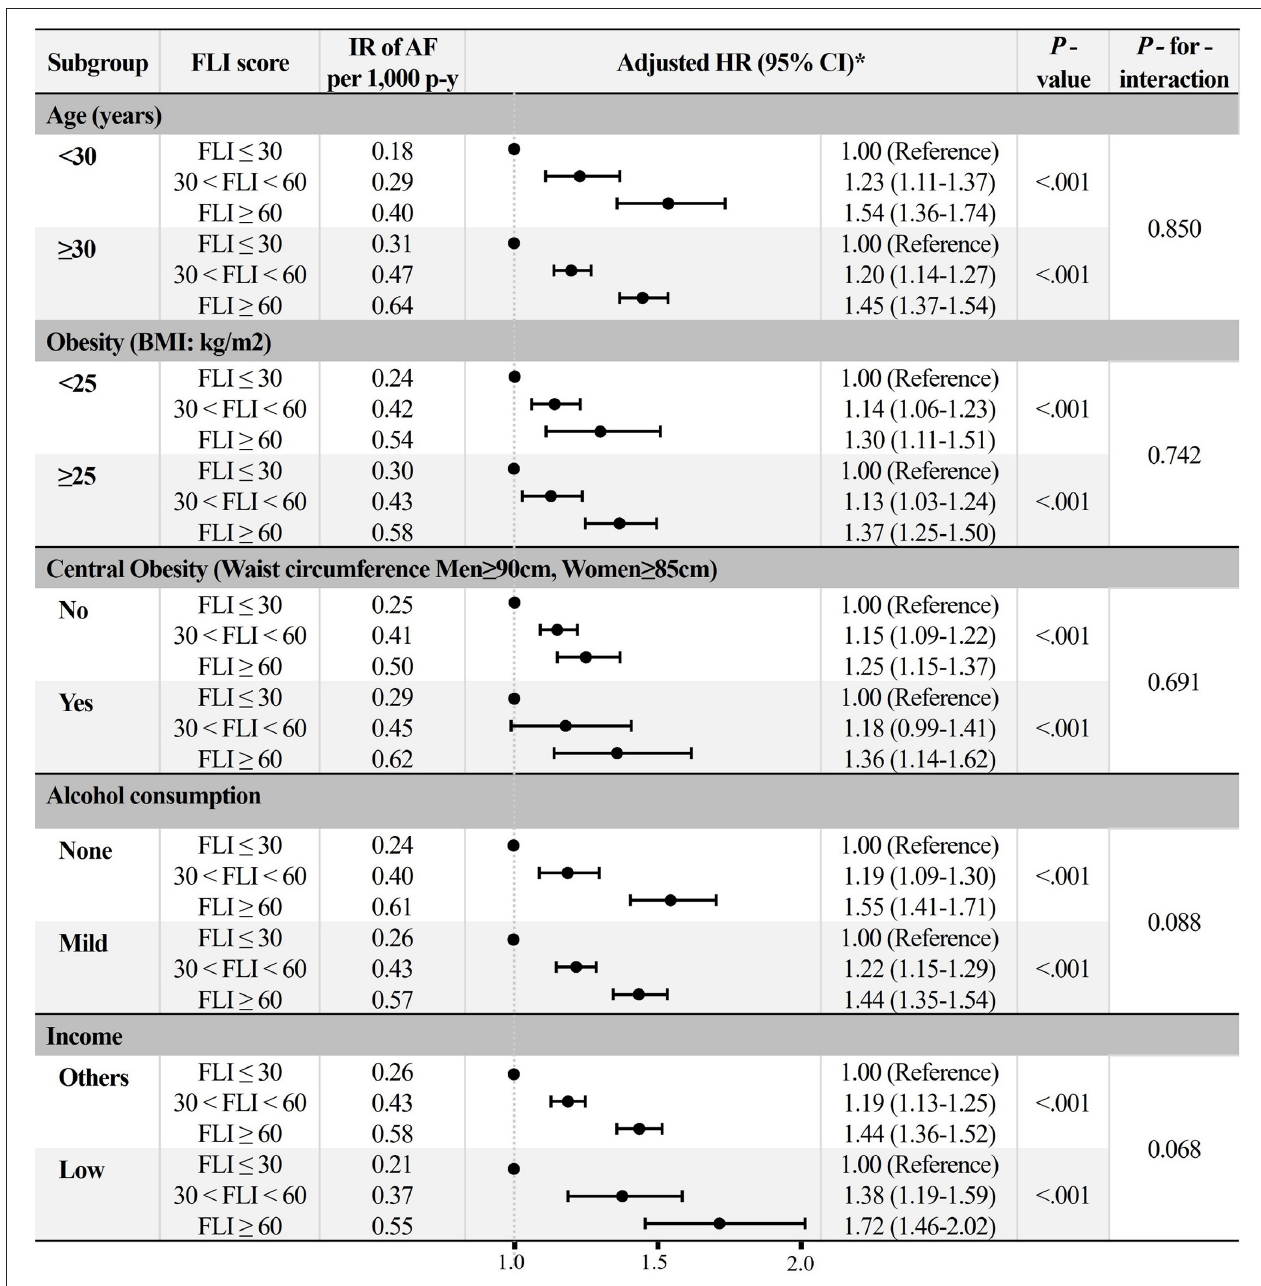
FIGURE 5 | Subgroup analyses. *Adjusted HR: Model 3 (age, sex, hypertension, diabetes mellitus, dyslipidemia, heart failure, prior ischemic stroke, prior myocardial infarction, chronic obstructive pulmonary disease, chronic kidney disease, sleep apnea, hyperthyroidism, smoking, alcohol consumption, and low income). AF, atrial fibrillation; BMI, body mass index; FLI, fatty liver index; HR, hazard ratio; IR, incidence rate.